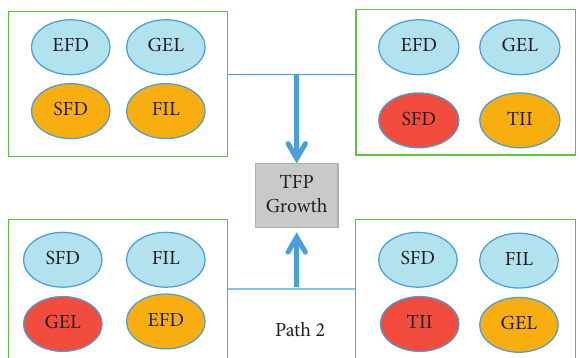
Figure 4: Paths to achieve high TFP growth. Note: the blue box represents the core conditions, the red box represents edge conditions, and the yellow box means that the element level is